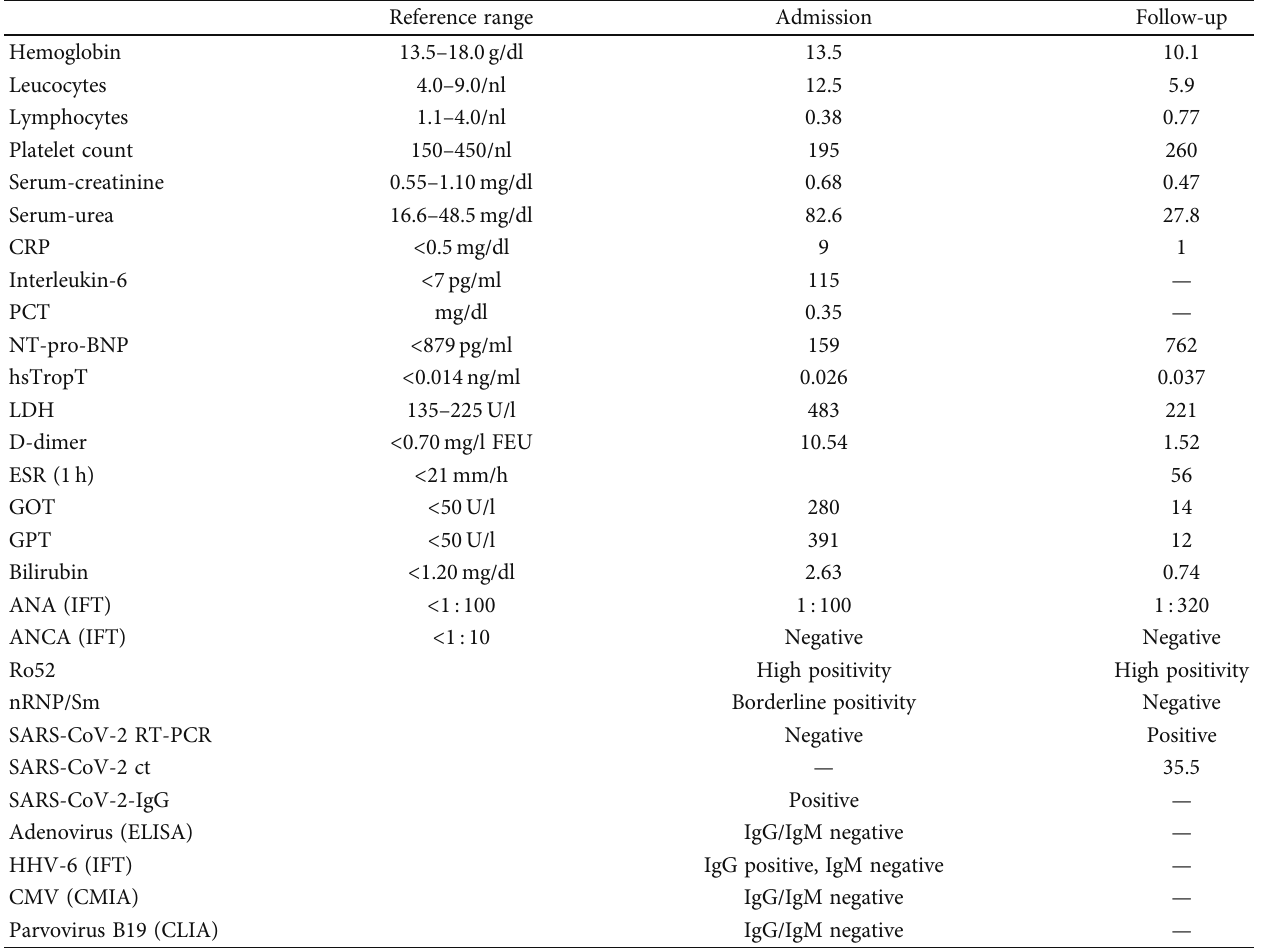
Table 1: Laboratory assessment at admission and